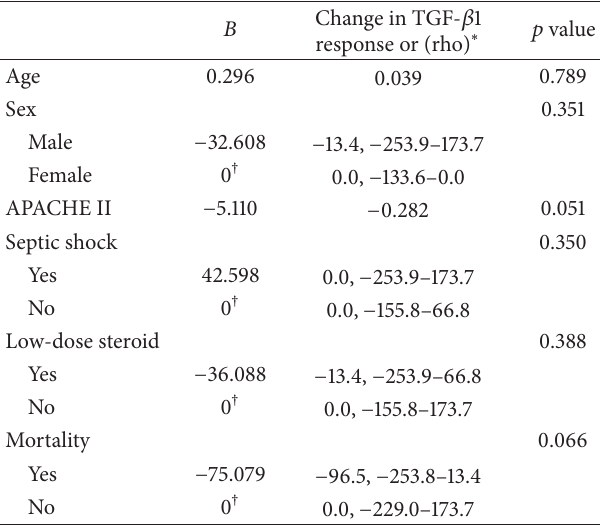
Table 7: Generalized linear model analysis for the change in TGF- 𝛽 1 response to identify independent factors among clinical characteristics and steroid